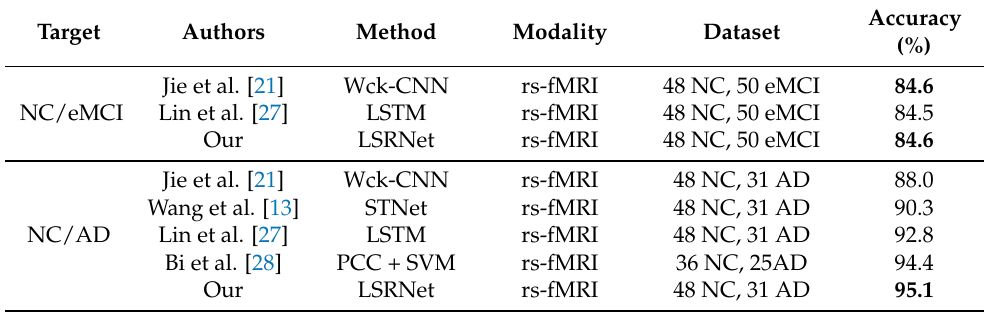
Table 4. Comparison with other